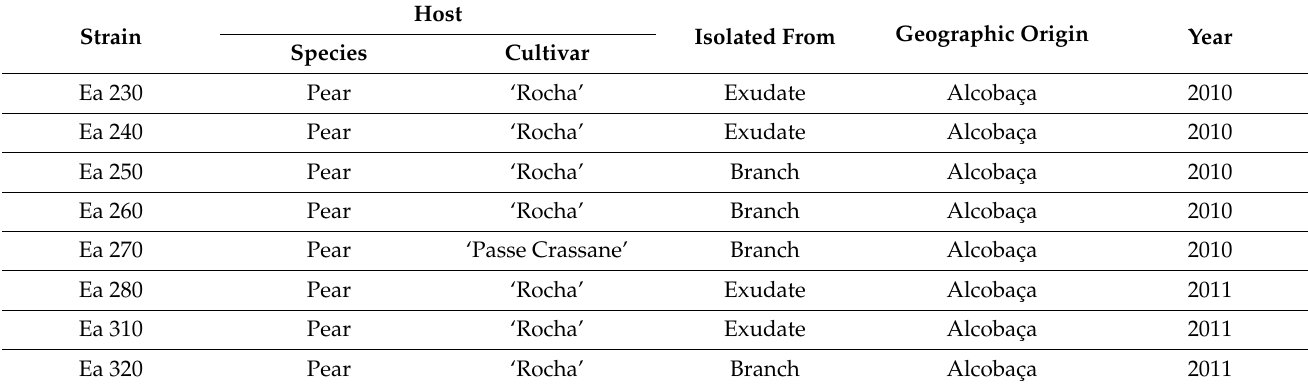
Table 2. Portuguese Erwinia amylovora strains used in this